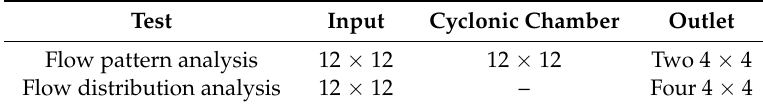
Table 1. Arrangement of wire-mesh sensors in each